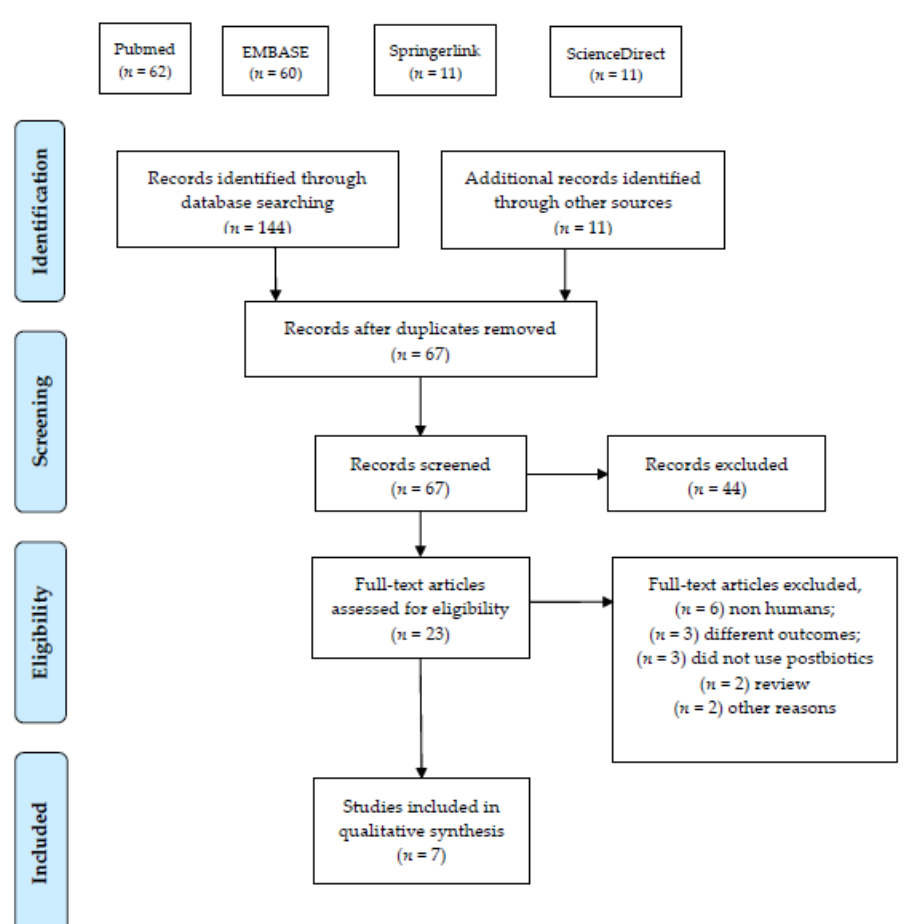
Figure 1. Identification process for eligible trials.